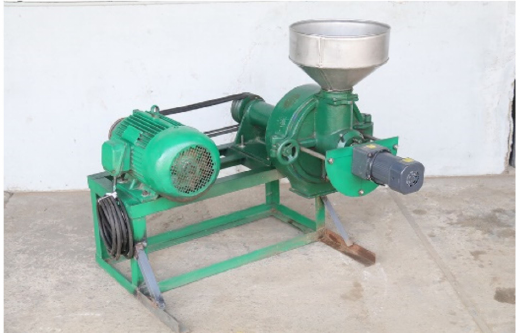
Figure 9. Rice straw fiber crusher test